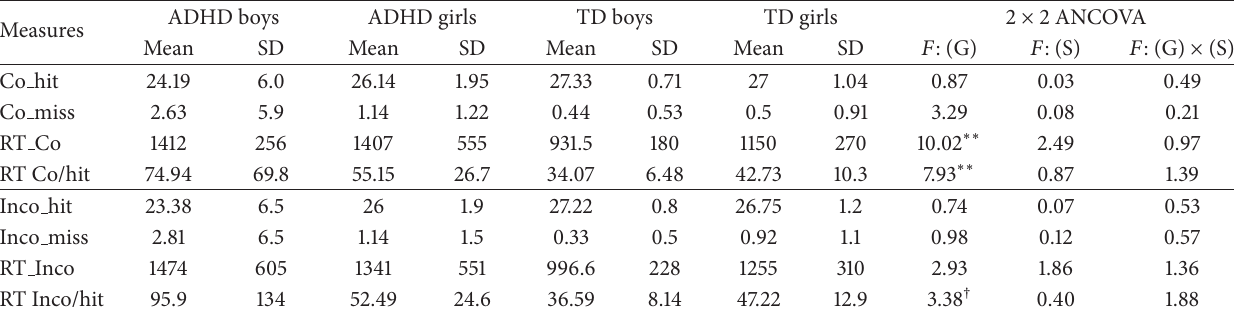
Table 3: Forethought performance in participants with ADHD and typically developing (TD)